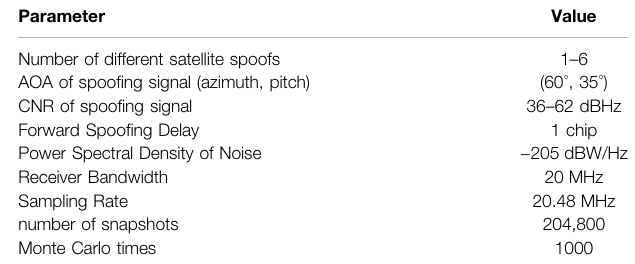
TABLE 3 | Parameter setting of spoo fi ng signal.